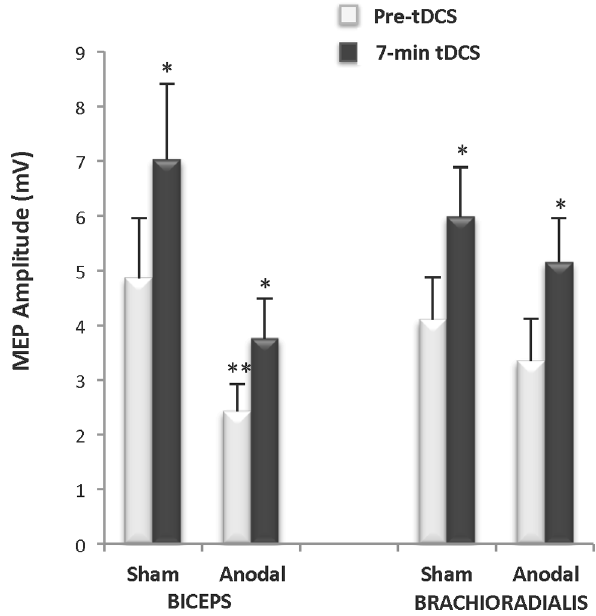
Figure 8. During-stimulation effects of tDCS and fatiguing contraction on cortical excitability for the Full-Time group (n=7). Motor evoked potential (MEP) amplitude was obtained in 7 of 8 subjects in the Full-Time group. Simulation condition x Time interactions were not observed for changes in MEP amplitude for either the biceps brachii or brachioradialis muscles ( p= 0.90). MEP amplitude increased in both muscles between the two times points in both muscles (*biceps: p =0.02 and brachioradialis: p =0.00). A Stimulation Condition main effect was observed for the biceps brachii (** p =0.04), as the MEP amplitudes prior to applying the anodal stimulation as well as after 7-min of delivering the anodal stimulation were significantly lower than those evoked during the sham condition ( p =0.05), although the percent change in amplitude between the two conditions was not significantly different ( p =0.56). No stimulation condition main effect was observed for the brachioradialis ( p =0.31).